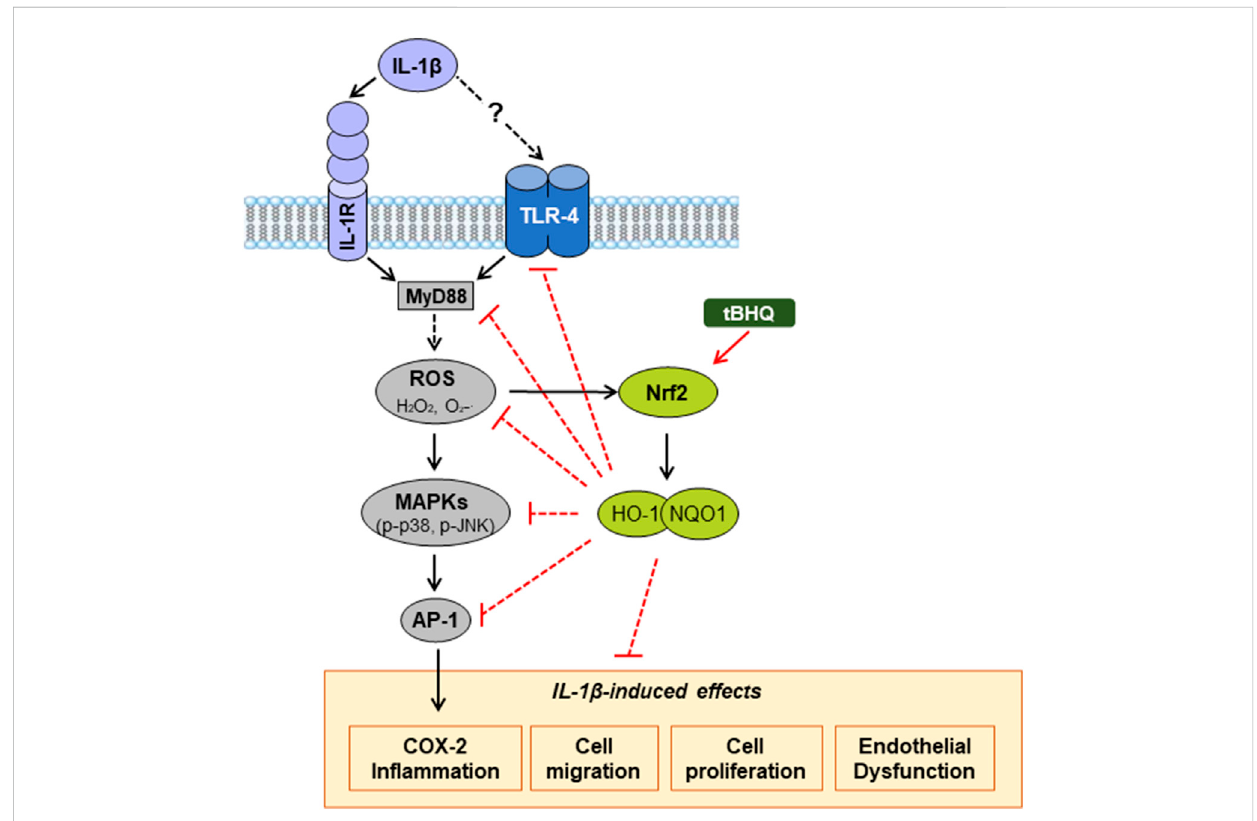
FIGURE 8 ProposedmechanismbywhichNrf2activationprotectsagainstvascularIL-1 β effects.IL-1 β increasesoxidativestressandinducesin fl ammation,cell migration and proliferation, as well as endothelial dysfunction, partially by a mechanism involving its interaction with TLR4 pathway. Nrf2 activation by tBHQ protects against these IL-1 β vascular deleterious effects. The dashed lines indicate additional mechanisms unexplored in our study. IL-1 β , Interleukin-1 β ; TLR4, toll-like receptor 4; MyD88, myeloid differentiation factor 88; ROS, reactive oxygen species; O 2 . − , superoxide anion; H 2 O 2 , hydrogen peroxide; tBHQ, tert-butylhydroquinone; Nrf2, nuclear factor-erythroid 2-related factor 2; HO-1, heme oxygenase-1; NQO1; NAD(P)H: quinone oxidoreductase 1; MAPK, mitogen-activated protein kinase; AP-1, activator protein-1; COX-2,